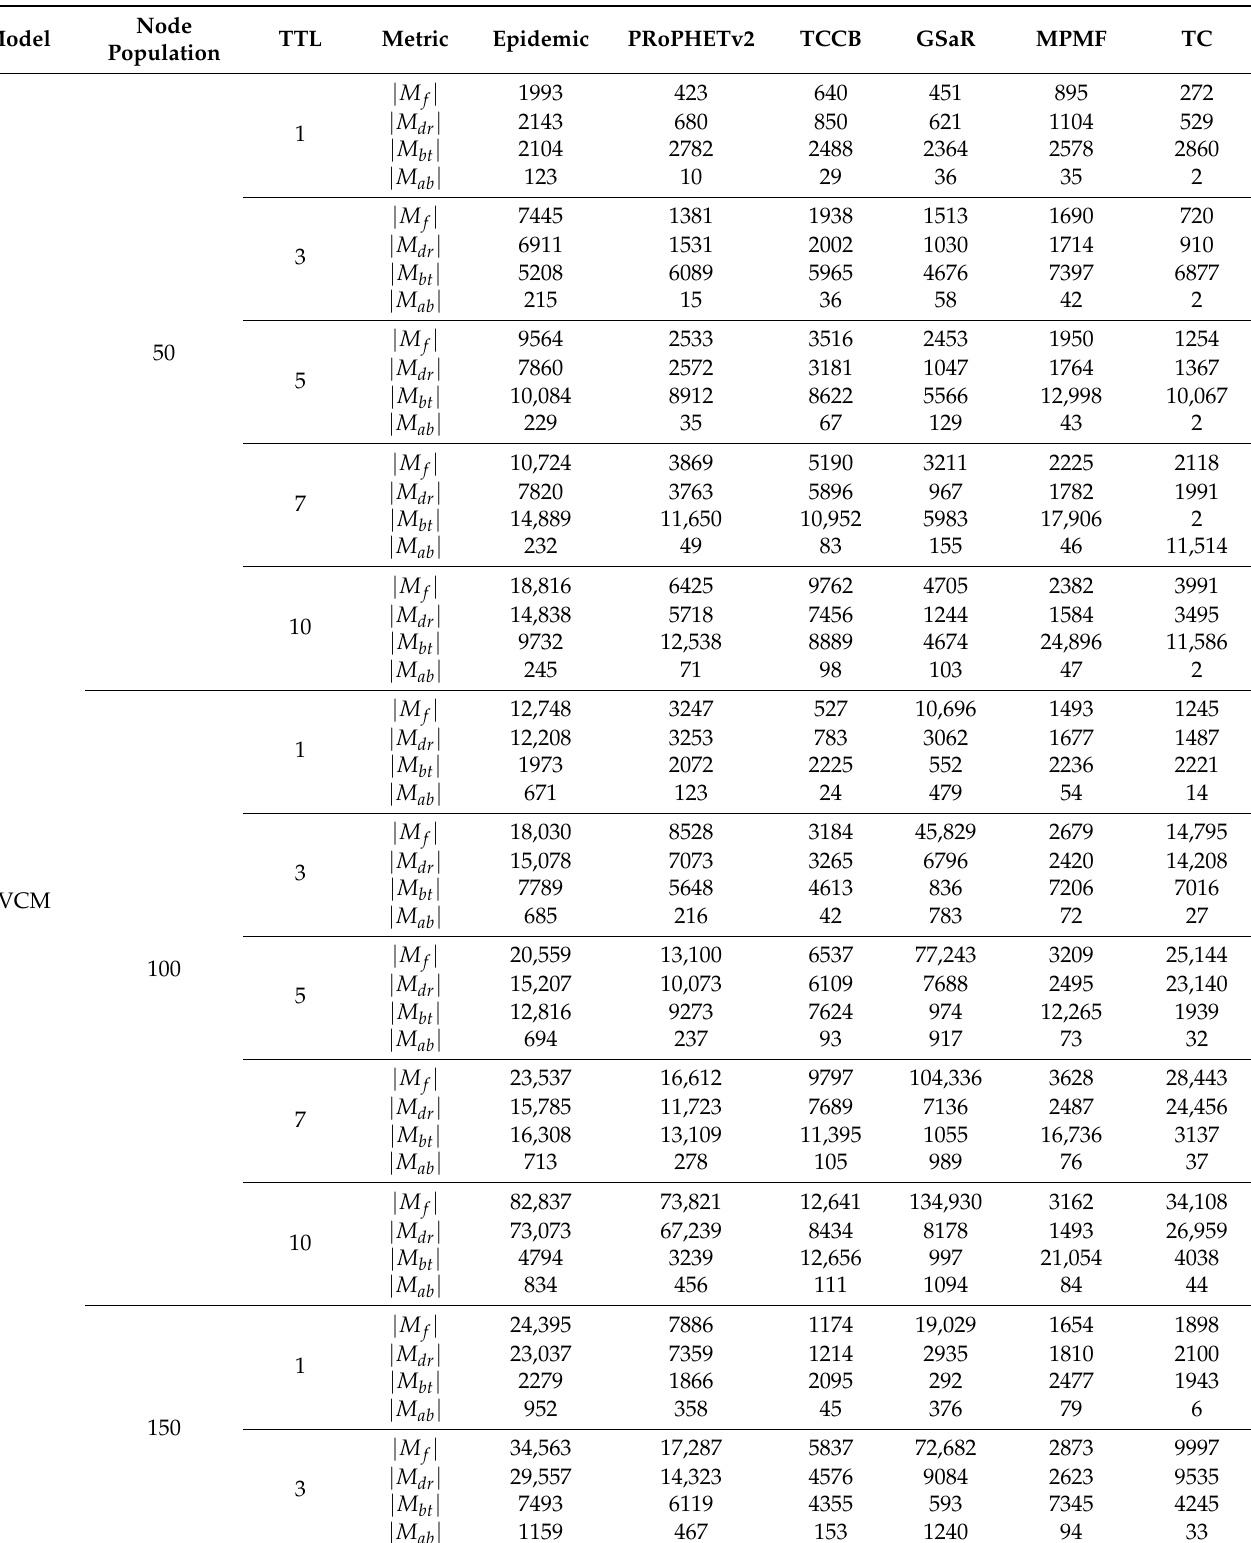
Table 2. Performance comparison between Epidemic, PRoPHETv2, TCCB, GSaR, MPMF, and TC policies.